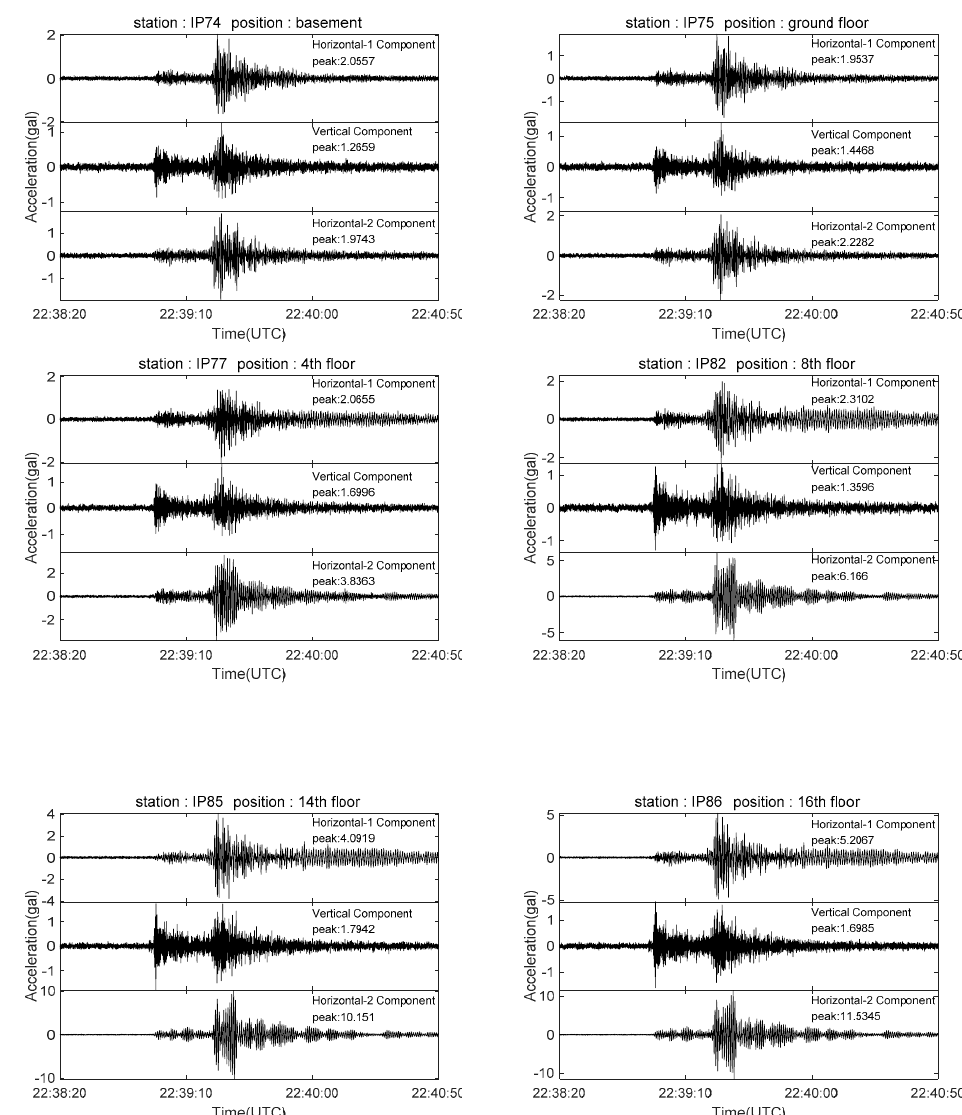
Figure 15. Seismograms from the Tangshan M5.1 earthquake that occurred at UTC 22:38:00, 11 July 2020. These seismograms were recorded on different floors of Beijing’s Building Monitoring Network. The hypocentral depth of the earthquake was 10 km. The building was 191 km away from the epicenter. The sensor’s sampling rate was 200 Hz. Additionally, the data were filtered by a bandpass filter of 0.1–20 Hz (the seismogram data for this study were provided by Beijing Earthquake Agency).